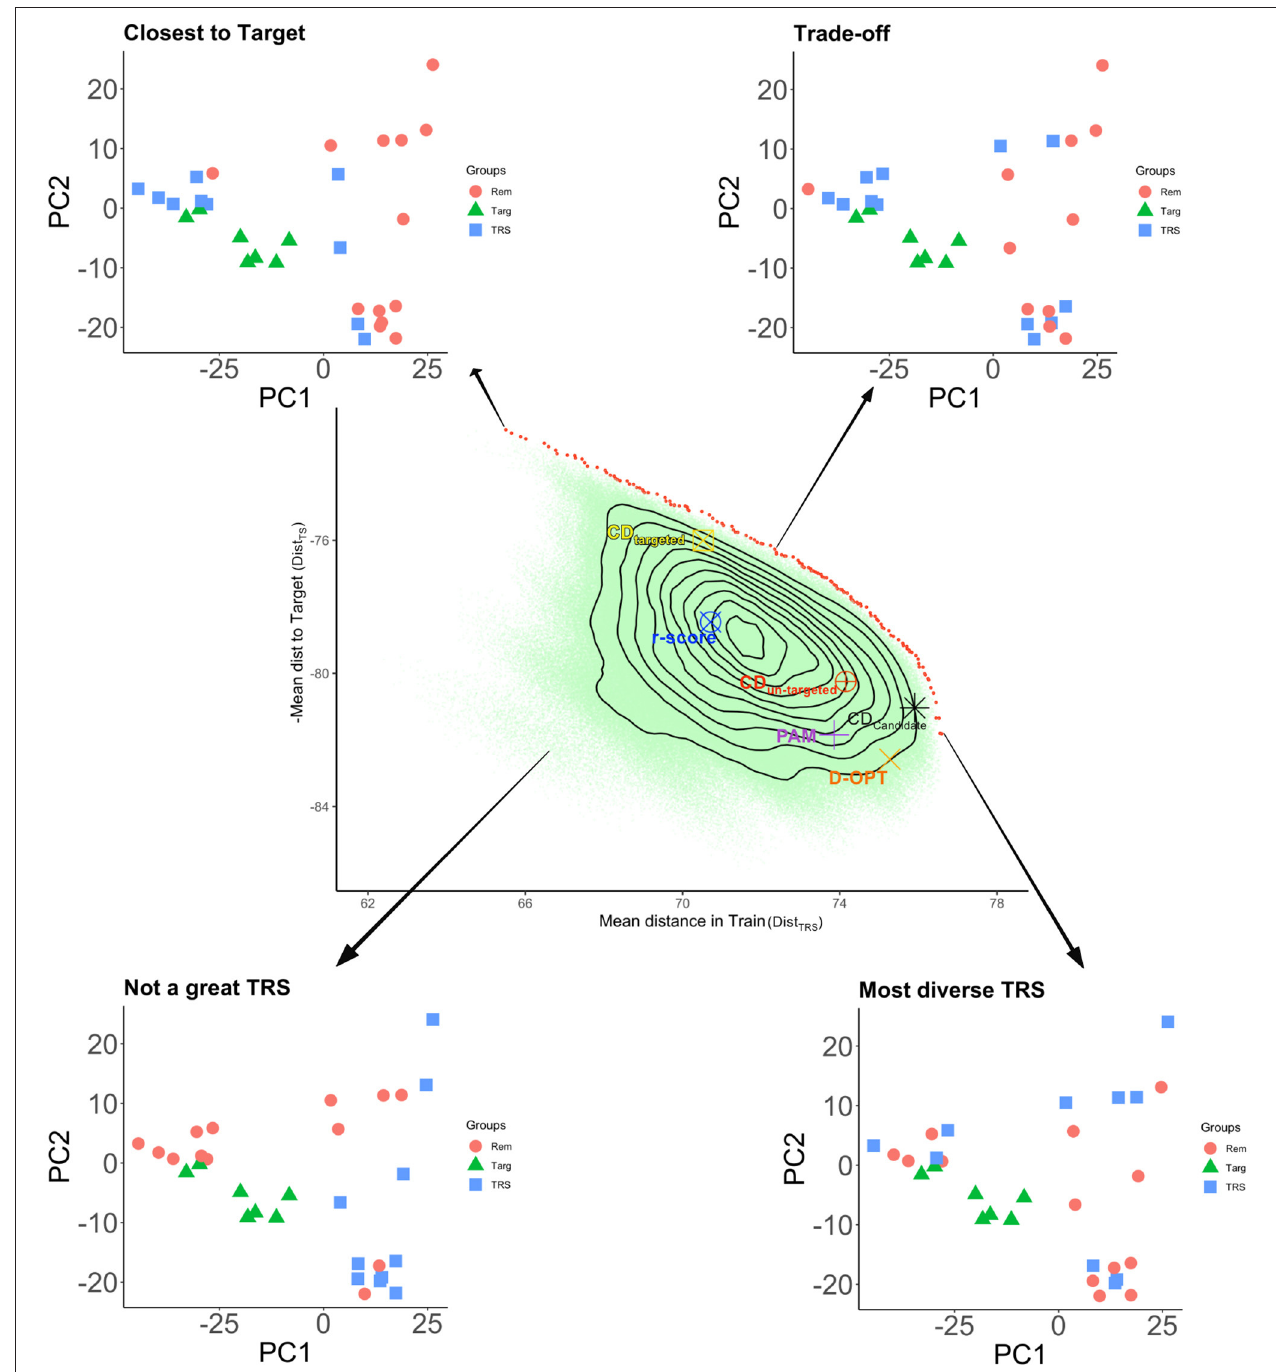
FIGURE 5 | Pareto front for minimizing the mean genomic distance of TRS genotypes to the TS genotypes (i.e., maximizing the negative of this quantity), and maximizing the mean genomic distance among the TRS genotypes. The figure represents a toy example where a sample of size 10 is selected from 23 candidate genotypes to predict 7 TS genotypes (the total number of different solutions is 23 choose 10 which is more than a million). Target genotypes along with selected TRS and the remaining sets are displayed in the genotypic space represented by the first two principal components of the marker matrix. With different symbols and colors, we indicate the optimal CD TRS’s for targeted and un-targeted cases, D-optimal TRS, and the TRS selected by PAM. The red dots are the TRS that are on the Pareto front, i.e., no other TRS will be better than any of these for both criteria (non-dominated solutions). All the brown dots are dominated by the same two criteria. We get the most diverse set when the mean genetic distance in the TRS is maximal. We get a TRS closest to the TS when we minimize the mean genetic distance (maximize the negative) of TRS to TS. All of the parametric design criteria and PAM are dominated. Among those, CDmean targeted gives a TRS that is close to the TS. The remaining optimal TRS’s are genetically diverse. The most genetically diverse set among the optimization criteria is the CDmean calculated for all genotypes in CS.